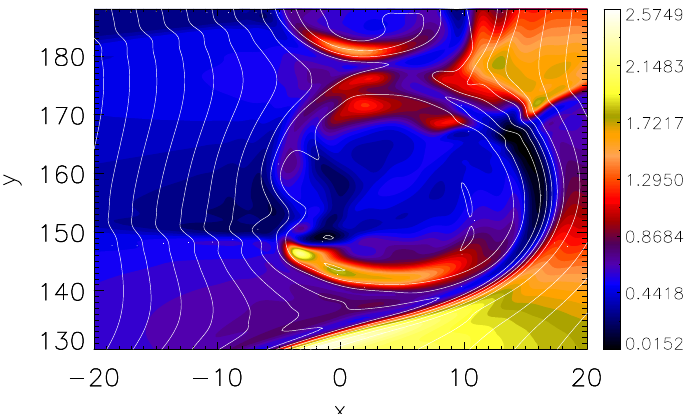
Figure 7. Isocontour of pressure P = P e + P i with overplotted magnetic field in the ( x , y ) -plane at t = 185 for the case V 0 = 7 showing a KH vortices detached from the velocity shear layer and completely plunged in the magnetosphere.